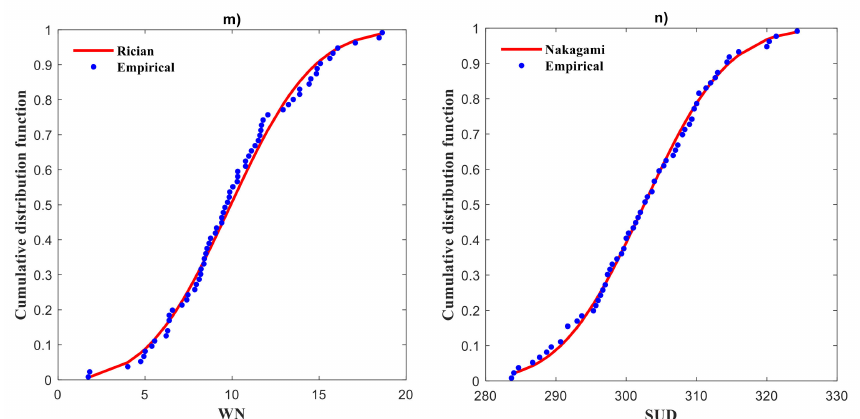
Figure 7. Observed data (blue dots) and fitted marginal distribution (red line) of the climate indices ( a ) R50MM, ( b ) D95P, ( c ) R20MM, ( d ) RTWD, ( e ) RX, ( f ) RX5D, ( g ) DD, ( h ) R95TOT, ( i ) R99TOT, ( j ) CSD, ( k ) WD, ( l ) CD, ( m ) WN, and ( n ) SUD averaged over 36 grid points in the Gomati river basin during 1951–2018.